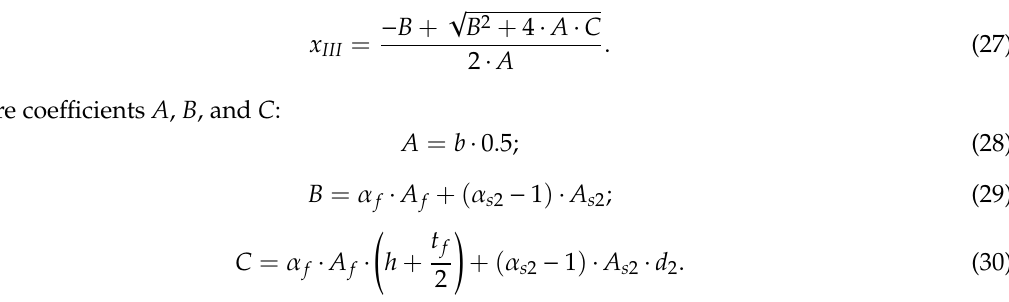
Figure 5. Stress-strain state in the strengthened RC beam when the yielding of reinforcement is reached: ( a ) Depth of the neutral axis; ( b ) distribution of strains; ( c ) distribution of stresses; ( d ) internal forces. The depth of the neutral axis at stage 3 is predicted by the